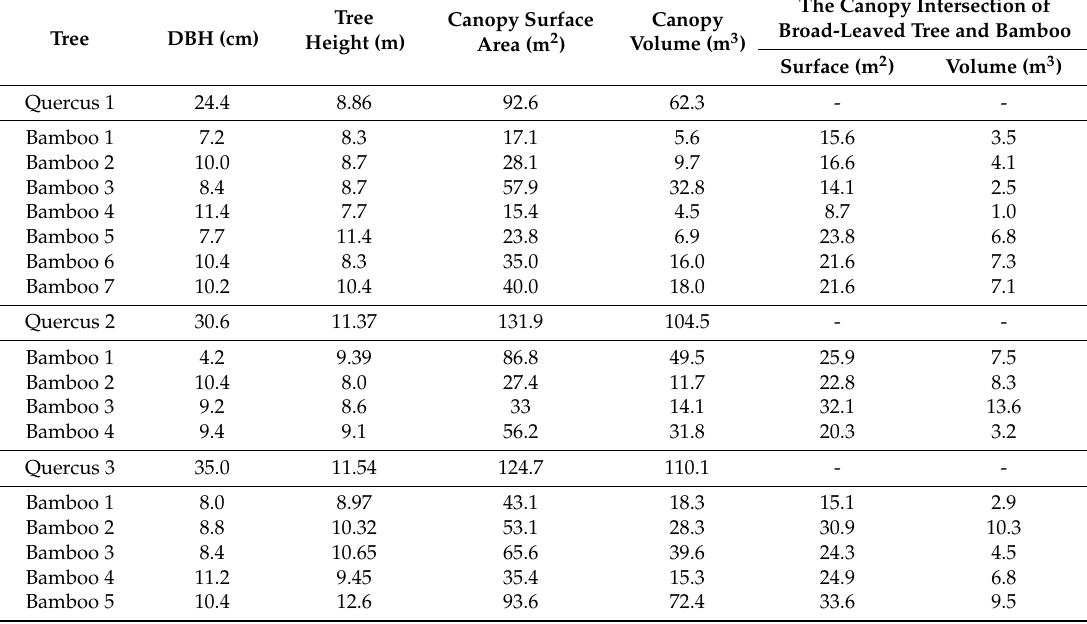
Table 7. Intersection of broad-leaved tree and bamboo crown.